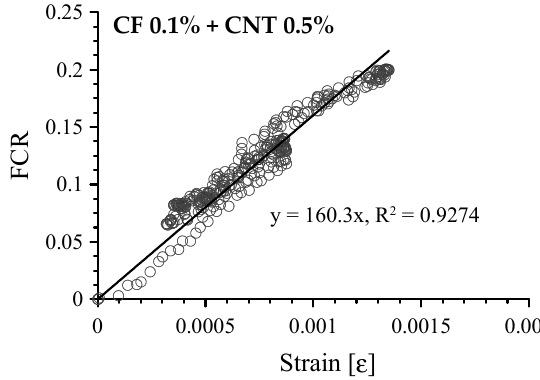
Figure 16. Correlation between FCR and compressive strain of cement-based composites with 0.1 vol.% CFs and 0.5 vol.% MWCNTs up to second stage of loading sequence.